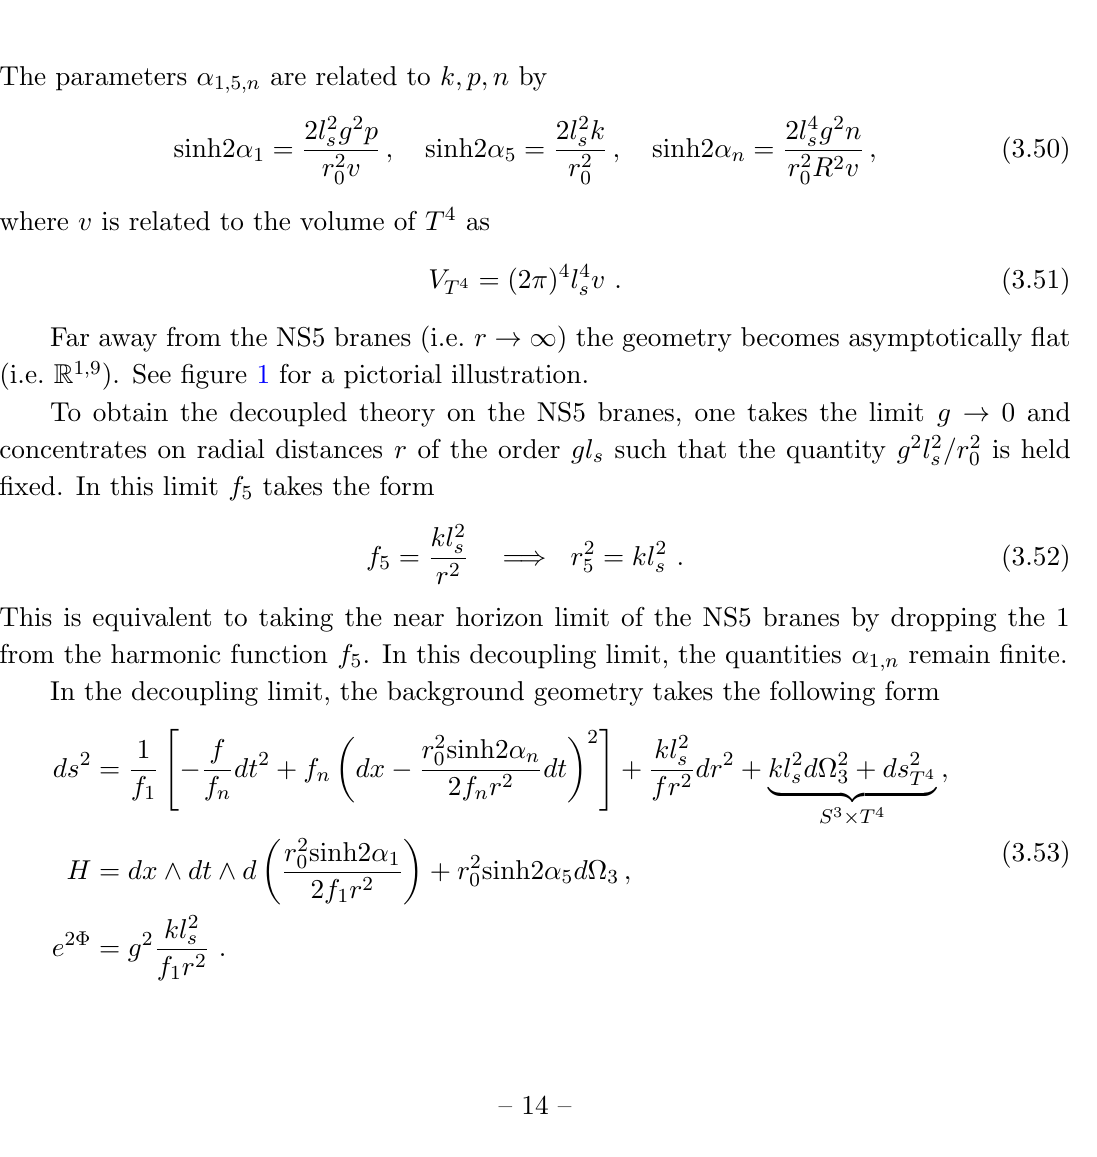
Figure 1 . The (cid:12)gure schematically shows the three distinct asymptotic regions of NS5+F1 system: (a) the asymptotic region far away from the NS5 branes is ten-dimensional (cid:13)at space, (b) the intermediate regime namely the near horizon geometry of the NS5 branes which is the linear dilaton regime and (c) the near horizon geometry of the F1 strings where the geometry is AdS 3 . The full near horizon theory of the NS5 branes (i.e. the shaded region in red) is described by the gauged WZW model SL(2 ; R ) k (cid:2) U(1) with the gauge currents given by U(1)